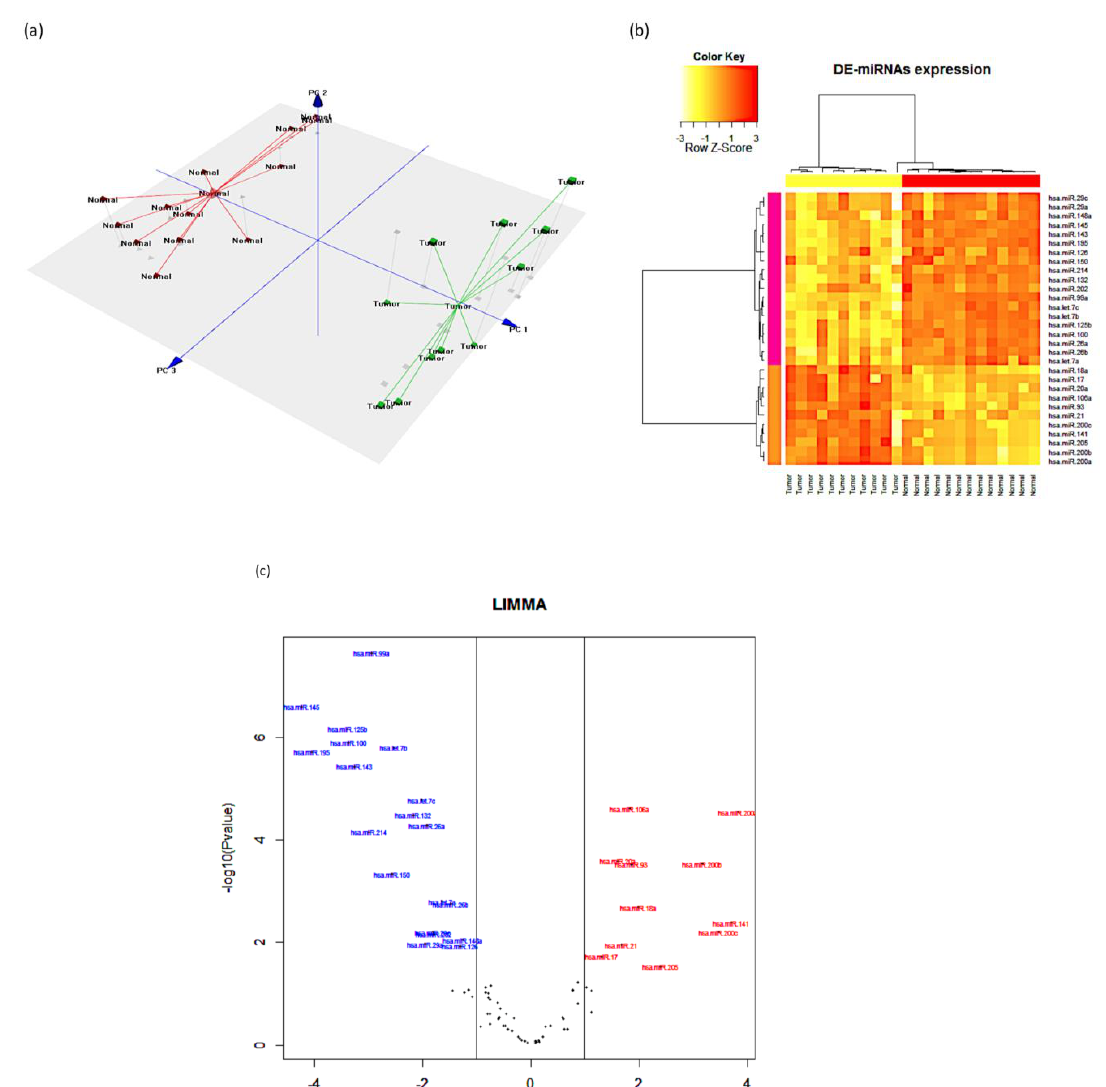
Figure 1. MicroRNA (MiRNA) expression profiling in metastatic serous ovarian cancer (SOC) compared to normal tissues. ( a ) Principal component analysis (PCA) shows the grouping of samples into cancer group (green lines) and normal (red lines). ( b ) Heatmap demonstrating the differentially expressed miRNAs in the tissue samples. Red shows upregulated miRNAs, and yellow shows downregulated miRNAs. ( c ) Volcano plot showing the relationship between the – log 10 p -value and the log 2 -fold change in metastatic SOC compared to normal.